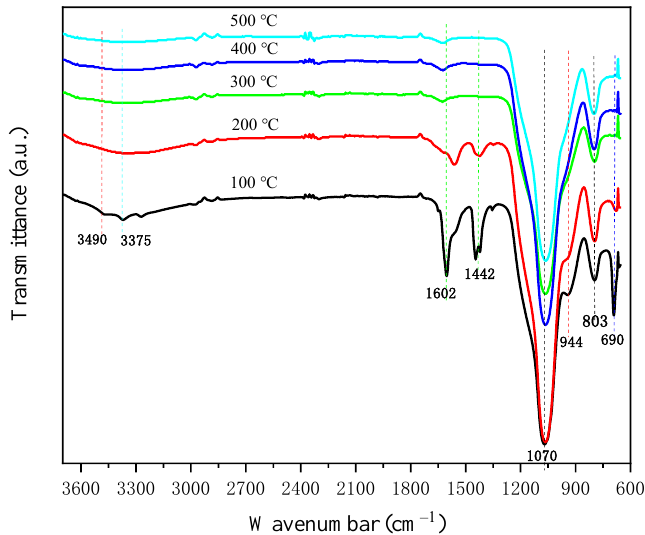
Figure 4. FT-IR spectra of 20% Cu-A-BM samples calcined at different temperatures.